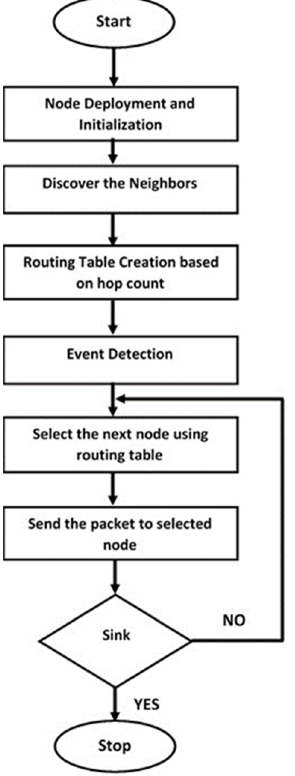
Figure 2. Working methodology of SOSRP.